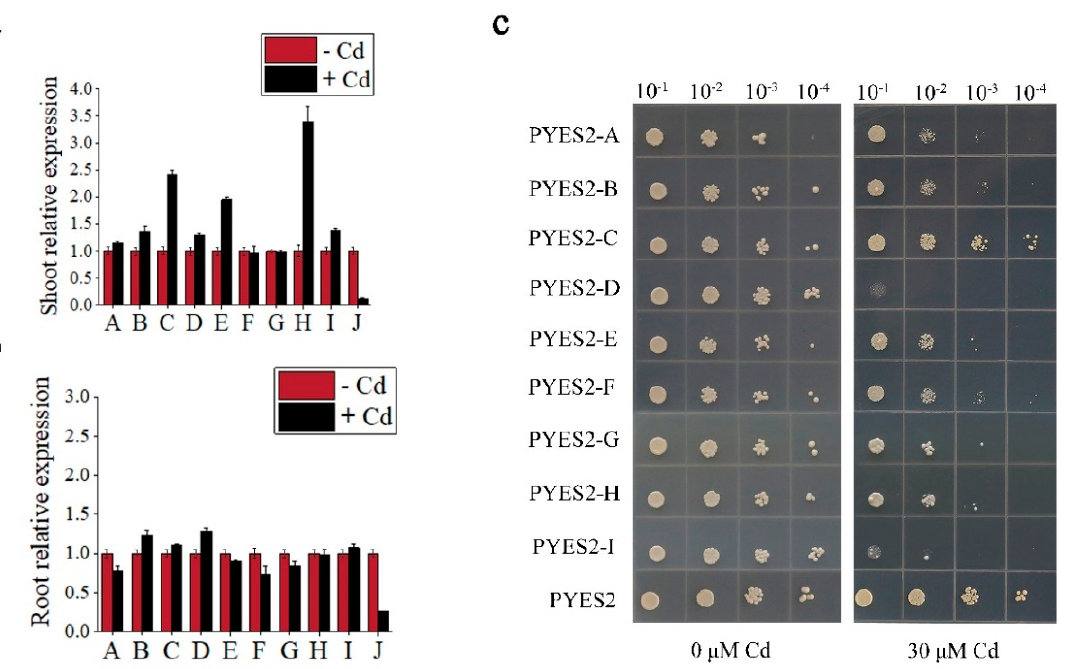
Figure 1. Screening of Cd uptake-related candidate genes. ( a , b ) The expression level of candidate genes in A. thaliana with or without 50 µ M Cd treatment. ( c ) Dilution-series spot assays of yeast strains treated with or without 30 µ M Cd. Error bars indicate standard deviation of means. Experiments in ( a – c ) were independently repeated three times with similar